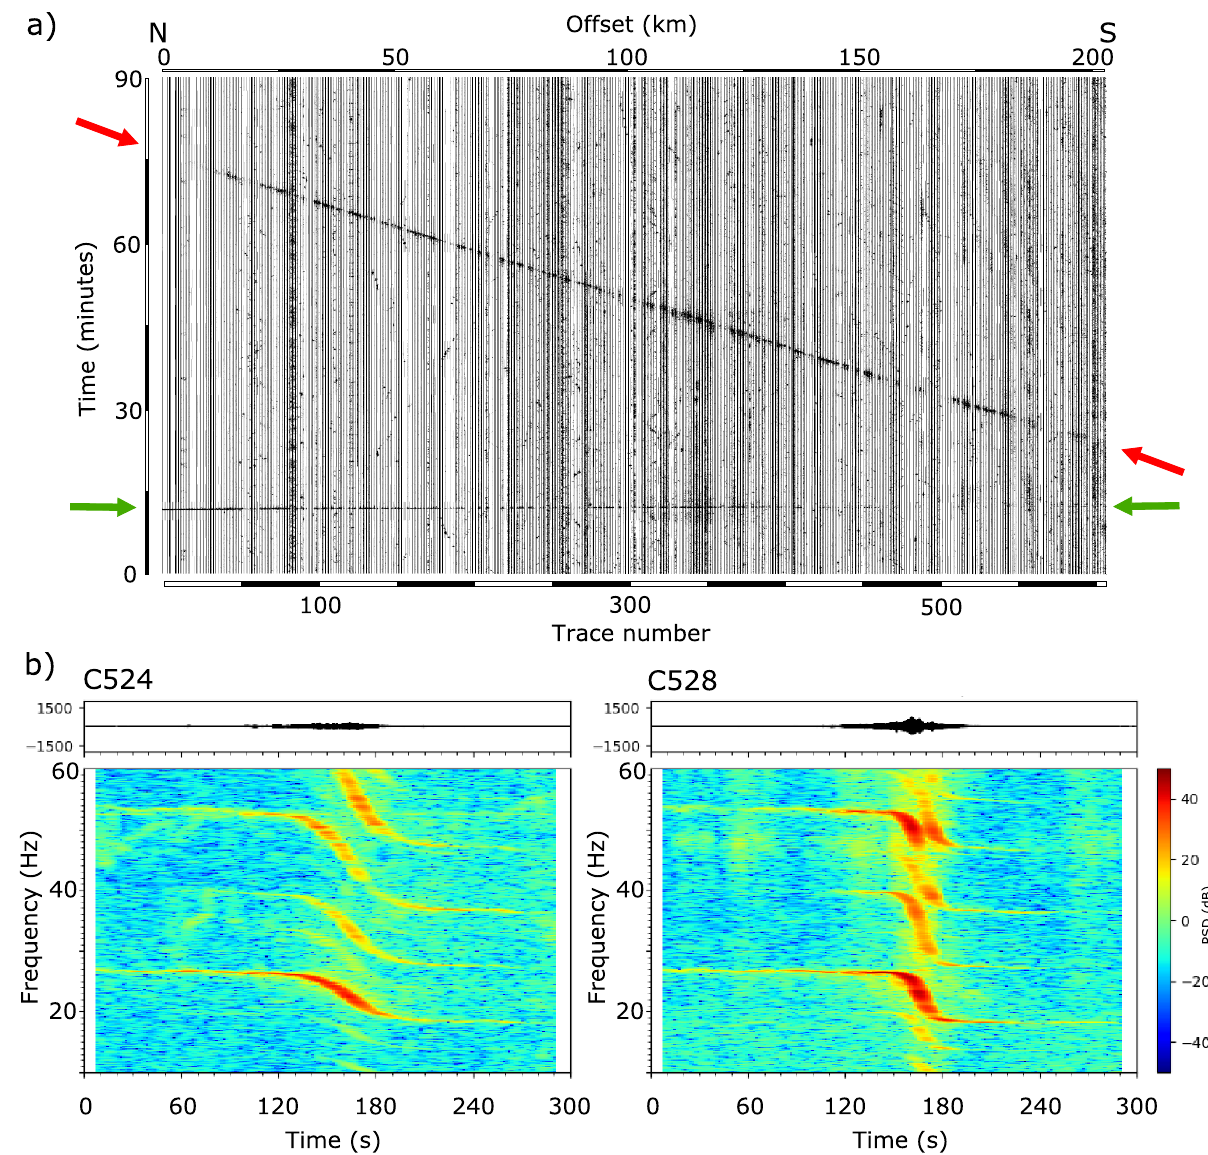
Figure 3. ( a ) Record section showing the signals generated by the CIMDEF controlled source (green arrows) and by a helicopter overflying the profile (red arrows). ( b ) Raw signals and spectrograms obtained for stations C524 and C528 during the time interval corresponding to the overflight of a